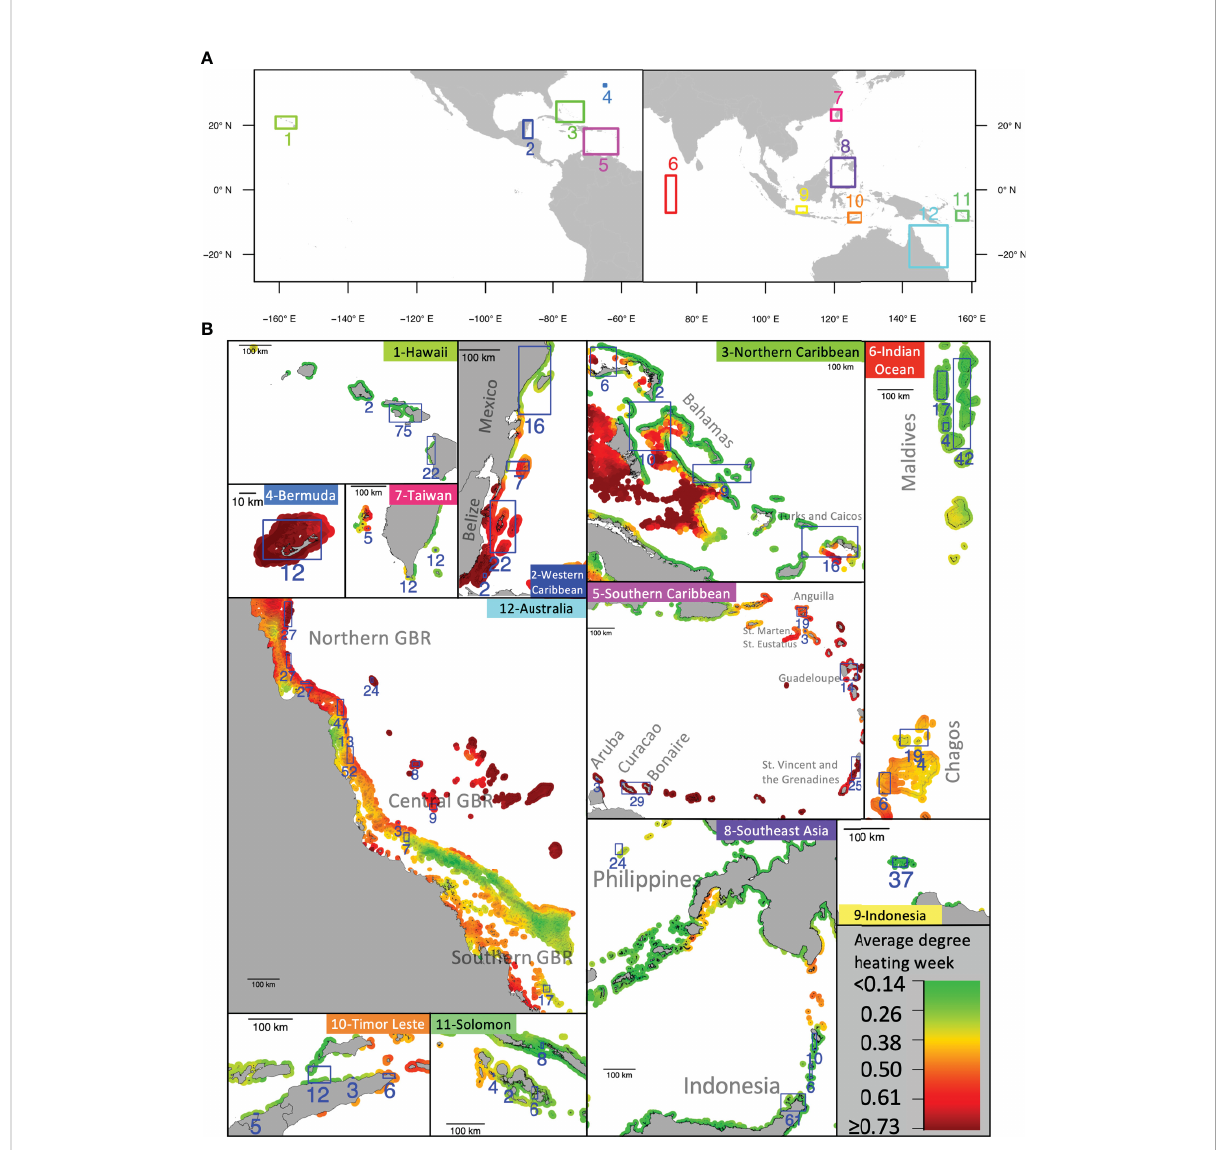
FIGURE 1 The study regions. (A) Distribution of the twelve study regions. (B) For each study region, the map shows the average monthly maximal Degree Heating Week (DHW) values for the 1985-2020 period. The blue squares indicate areas where coral cover surveys from the Catlin Seaview Surveys project were performed, with the numbers corresponding to the number of surveys per area. The reef surfaces were derived from the “ Global Distribution of Coral Reefs ” dataset of the UNEP (UNEP-WCMC et al.,